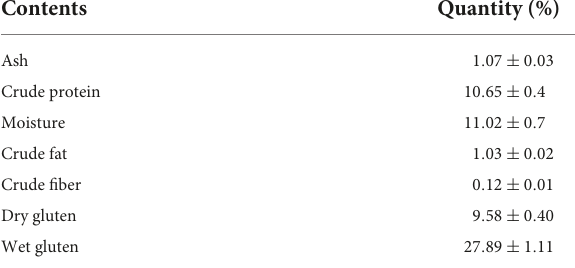
TABLE 10 Proximate composition of wheat flour purchased from Faisalabad market.